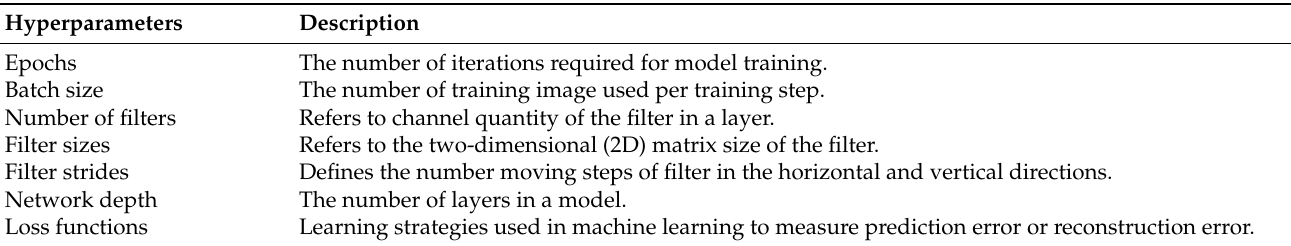
Table 8. List of hyperparameters required to define a deep learning